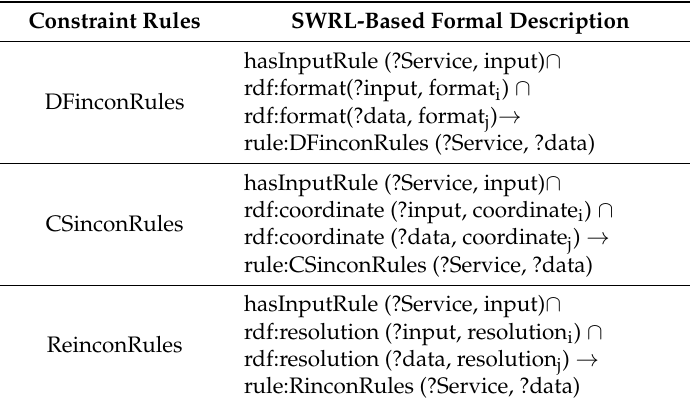
Table 3. SWRL-based formal description of constraint rules.